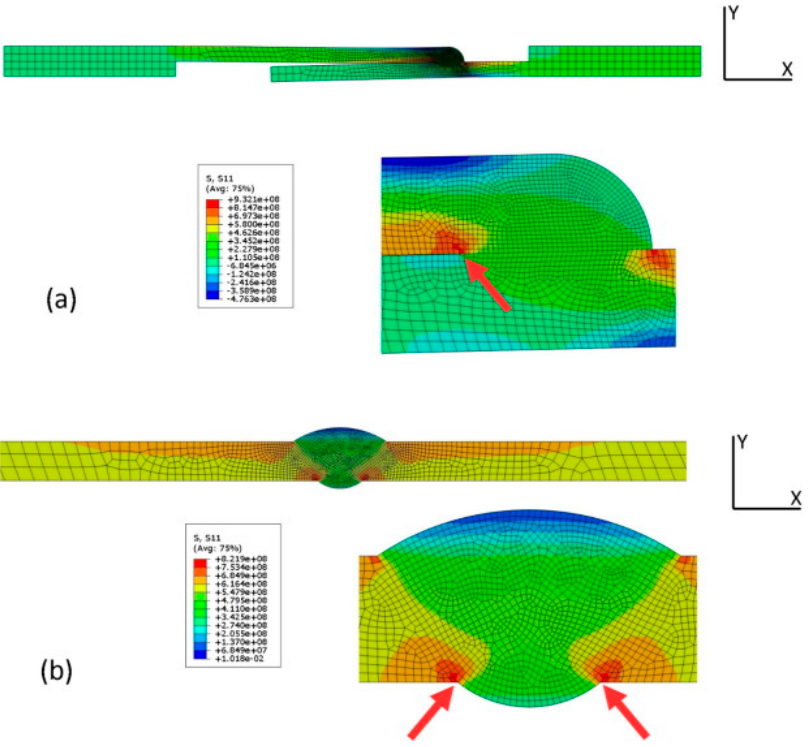
Figure 15. The stress distribution in the X direction corresponds to peak load: ( a ) single-lap shear and ( b ) butt weld. The maximum stress is shown by red arrows. Reprinted with permission from ref. [133]. Copyright 2016, Elsevier.